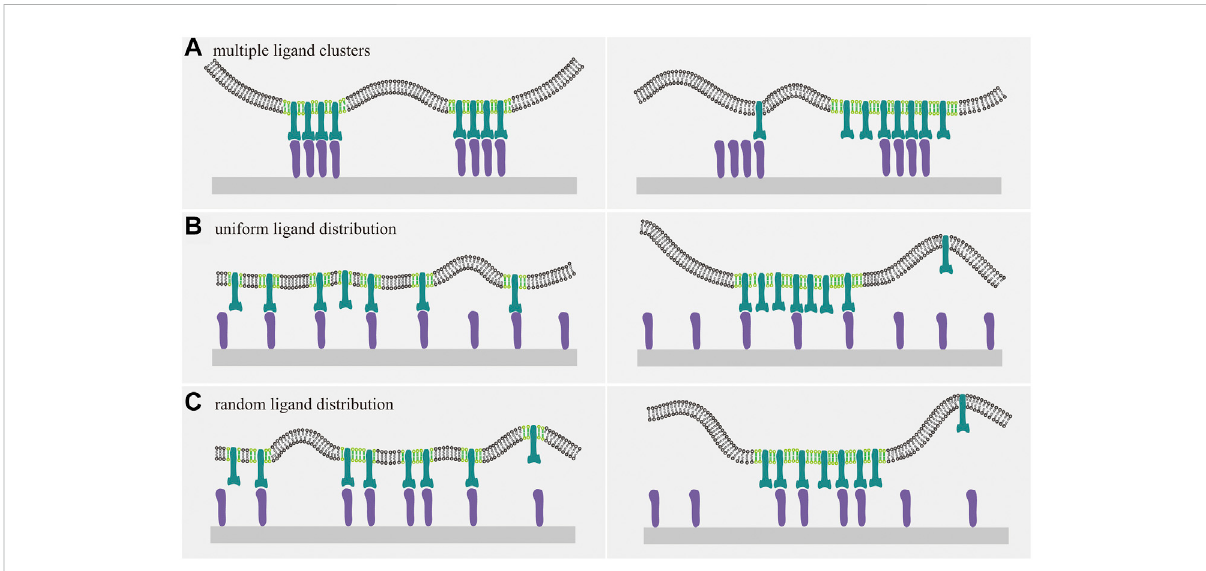
FIGURE 2 Cartoons of membranereceptorsbinding to ligands immobilized ona planar substrate. The interplay betweenreceptor-ligand binding and raft domain formation depends on the distribution of the immobilized ligands. Receptors, ligands, and lipid rafts are indicated with the same color as in Figure 1. (A) For multiple ligand clusters, the receptor-ligand binding inhibits the coalescence of rafts into large domains, since the release of raft- associatedandligand-boundedreceptorsisrequiredfortheformationoflargeraftdomainsandenergeticallyunfavorableduetothereceptor- raft coupling energy and receptor-ligand binding energy, as evident from the comparison between the right and left panel. For uniform (B) and random (C) distribution of immobile ligands, receptor-ligands binding disfavors the coalescence of lipid rafts and vice versa. This interplay can be understood by considering the energetic penalty as discussed in (A)